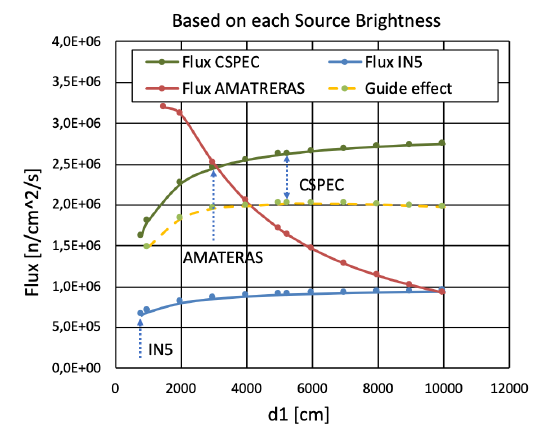
Fig. 7. Expected flux as a function of d 1 for a given resolution of 3% for Ei = 3meV for single